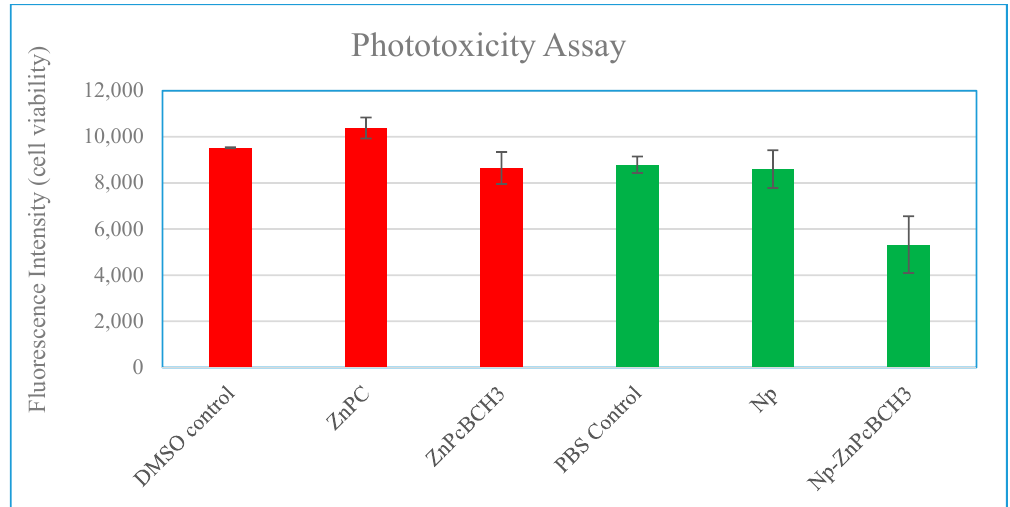
Figure 10. Phototoxicity of the encapsulated ZnPcBCH 3 vs free dyes. The A549 cells were exposed to 80 ng of ZnPc or ZnPcBCH 3 free dye versus 0.158 ng of ZnPcBCH 3 encapsulated into the PEG-b-PLGA nanoparticles . The viability of the A549 cells after dye treatment and light exposure was measured using the CTB